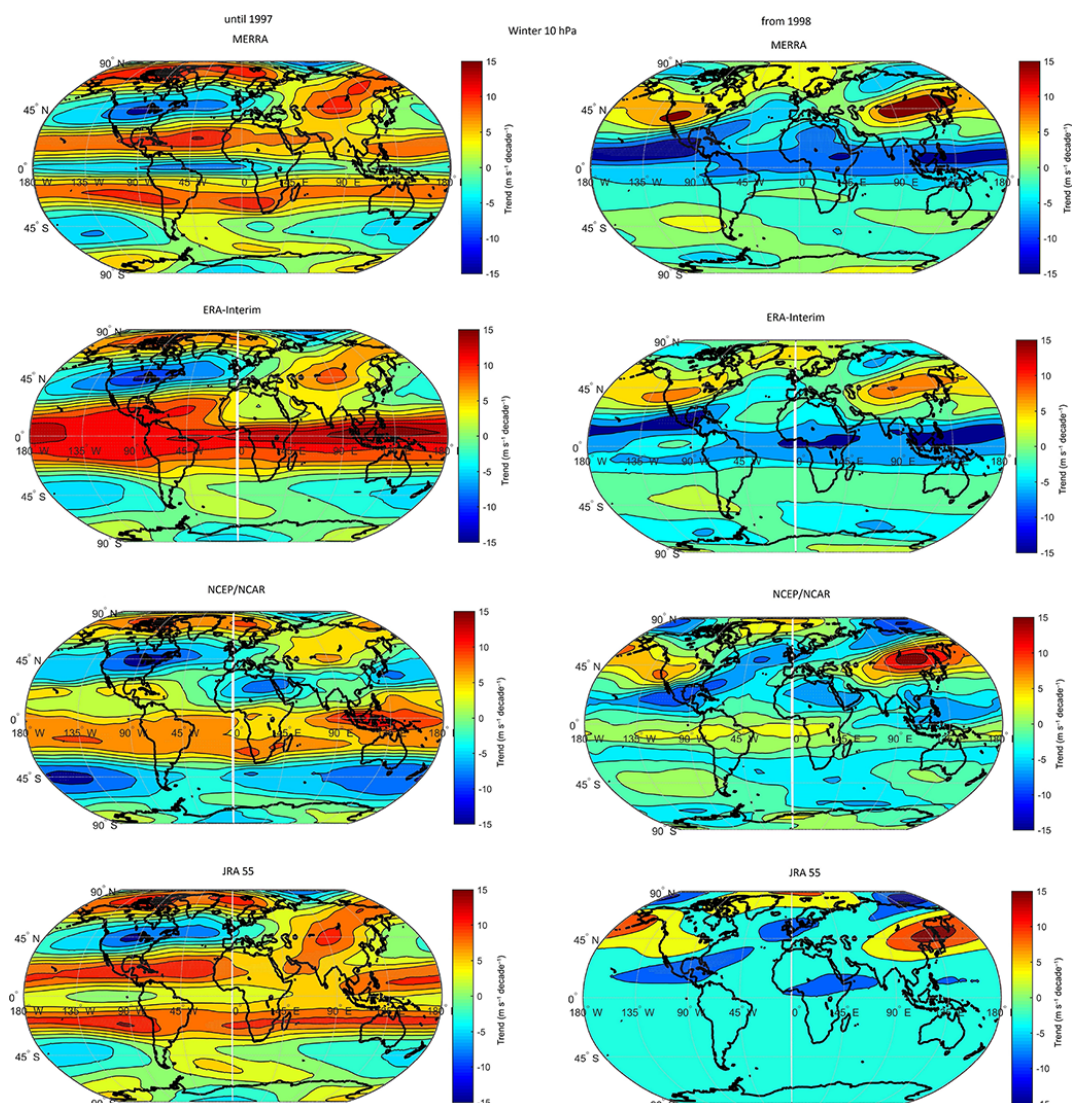
Figure 3. Zonal wind trends (ms − 1 decade − 1 ) for the winter season (October–March) at 10hPa from MERRA, ERA-Interim, NCEP/NCAR and JRA-55 reanalyses (top-to-bottom). Left panels show 1979–1997, right panels show 1998–2015 and statistical significance (95%) is highlighted by white